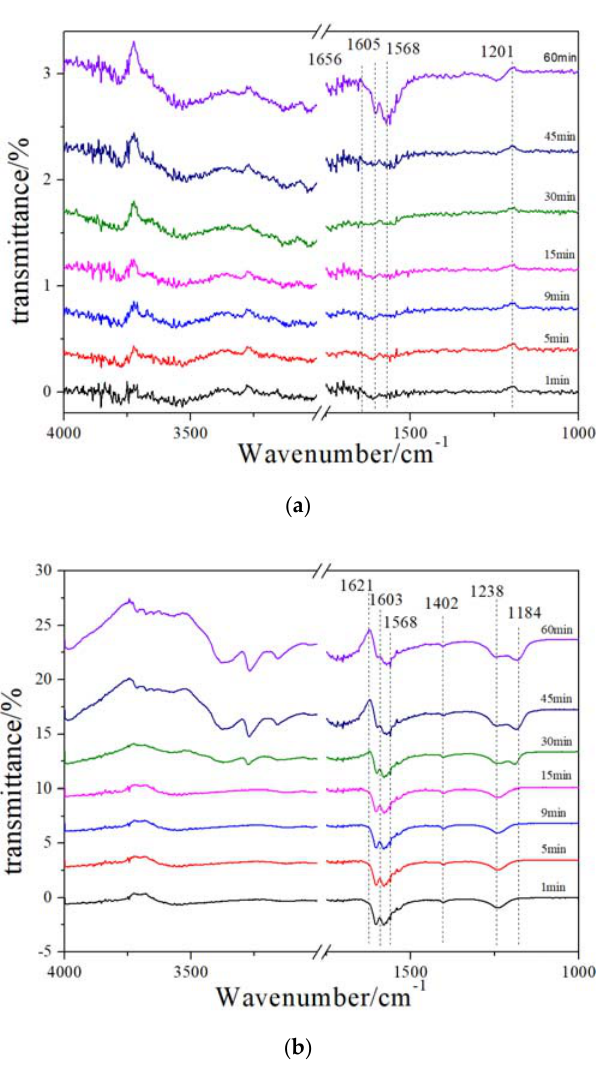
Figure 10. In situ DRIFT spectra of NH 3 reaction with pre-adsorbed. NO + O 2 over Ce/Ti-400 ( a ) and Ce-Ti-400 ( b ) at 240 °C.